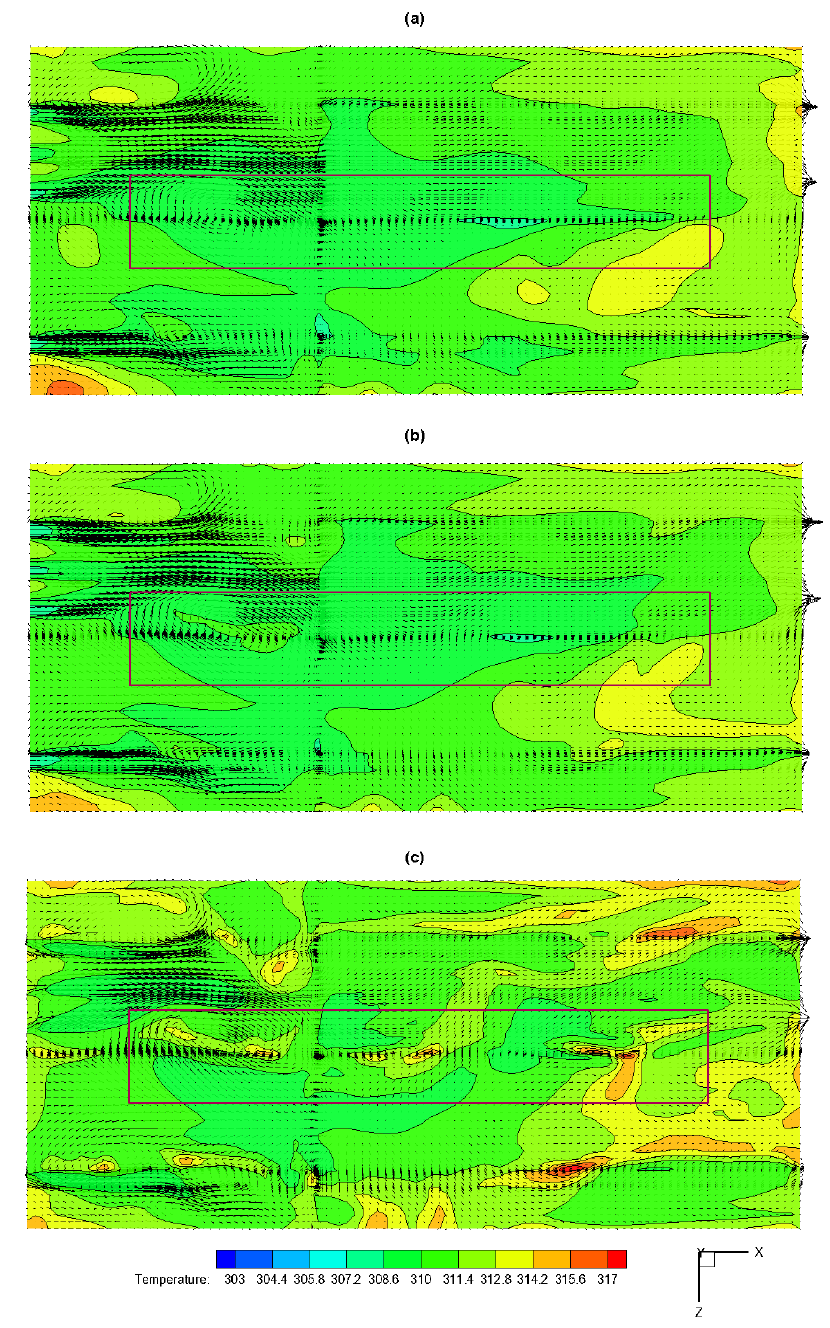
Figure 15. Temperature contours and air velocity vectors at three heights (Y plane): ( a ) 1.5 m, ( b ) 1.0 m, ( c ) 0.3